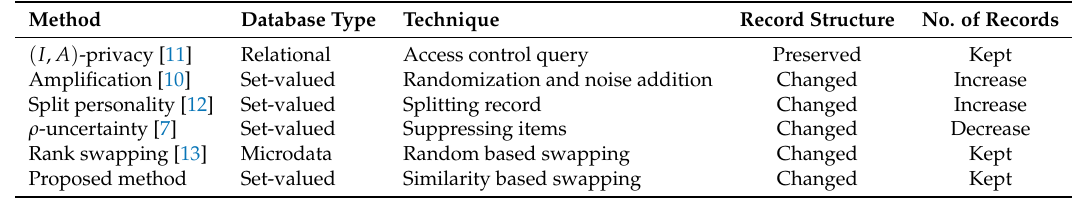
Table 2. Comparison of methods protecting personal sensitive information and personal